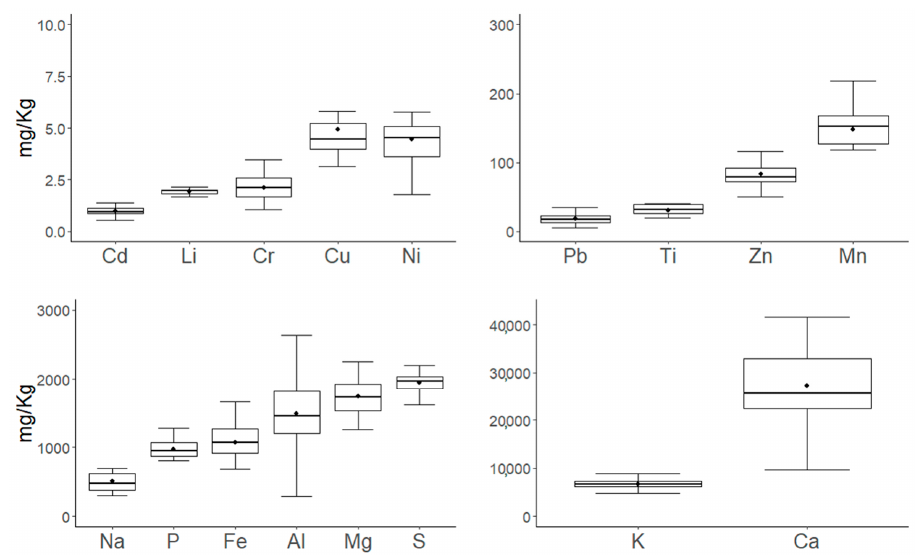
Figure 2. Boxplot shows the concentrations observed after a 1-month exposure of each considered element. Horizontal lines show the median values, while the point indicates the mean value. The potential contamination level and risk linked to trace elements in the atmospheric aerosol was carried out using ecological indices. The analysis of the concentration of trace elements and the application of ecological indices may be considered as an important and useful method for evaluating the natural environment and the possible environmental hazards due to human impact. Therefore, the possible atmospheric contamination of each element in High Sauro Valley was assessed using two indices, the contamination factor (CF) and the pollution load index (PLI). The CF values used in this study differ slightly from the EC (exposed-to-control) ratio described by the authors of [54], who used the concentrations of trace elements in pre-exposed lichens as control values. In this study, lichens previously collected at an unpolluted area in the Basilicata region in 2011 [20] were chosen as background samples The CF values for each of the 17 trace elements analyzed range from 0.9 to 1.9. Particularly, the air pollution level of trace elements in the study area was estimated as not contaminated (C1) for Cr, Fe, Li, Mn, Ni, P, Pb S, Ti and Zn showing values <1.2 and slightly contaminated (C2) for the other trace elements such as Al, Ca, Cd, Cu, K, Na and Mg, that showed values ranging between 1.3 and 1.9 (Table S3 in Supplementary Material). The pollution load index (PLI) was assessed. A characteristic feature of this index is that it indicates mainly how many times the natural content of the studied metals was exceeded in the sampling site. Following the scale proposed by Tomlinson et al. [38], the results highlighted that 30% of the sampled points showed a PLI less than 0.9 or approaching 1 (1 ± 0.1), indicating no contamination or an air pollution load close to the background level. All the remaining